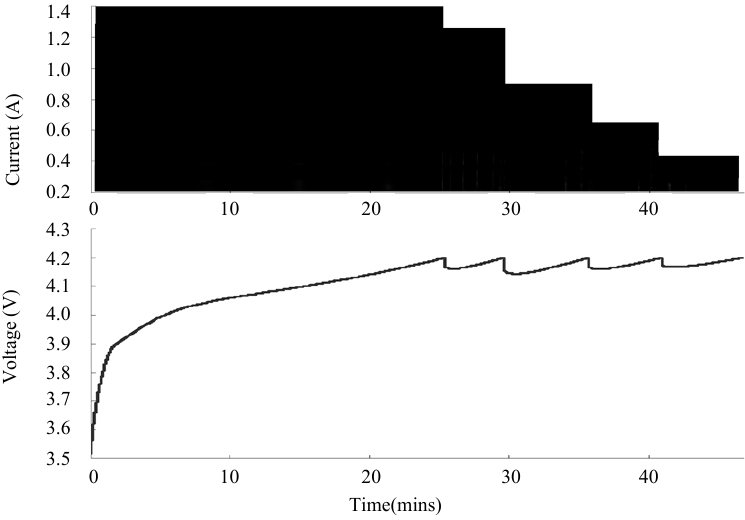
Figure 11. Measured profiles of charging current (A) and charging voltage (V) of a single battery cell implementing the proposed multistage pulse charging method (min).